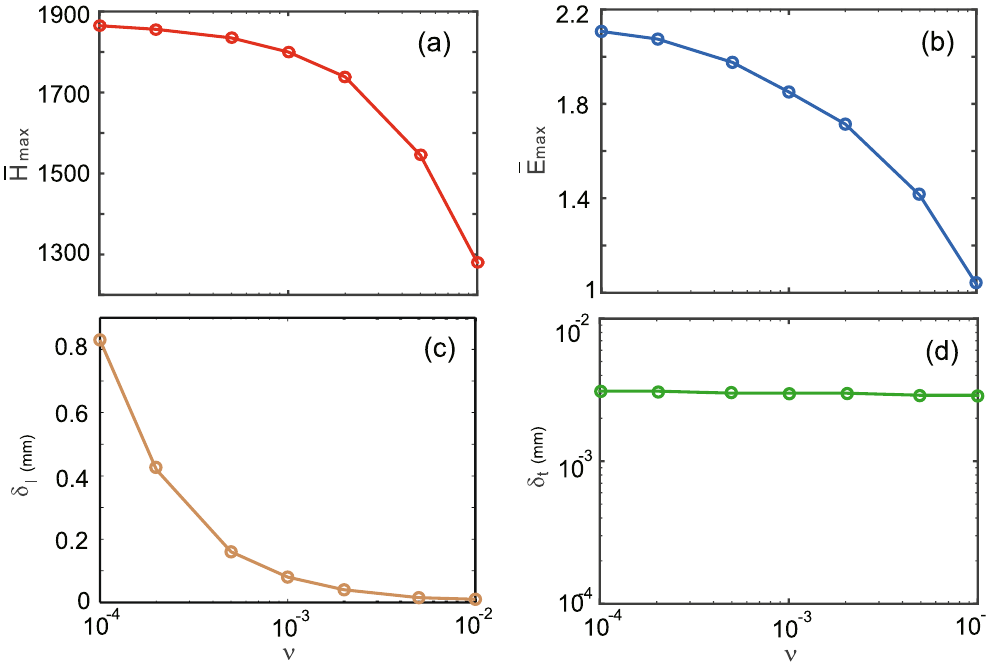
Figure 4. Dependences of H the same as in Fig.